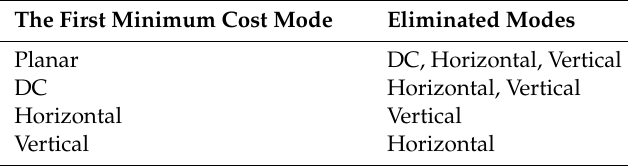
Table 1. Mode pattern table to eliminate the candidate modes in the rate-distortion (RD) list.